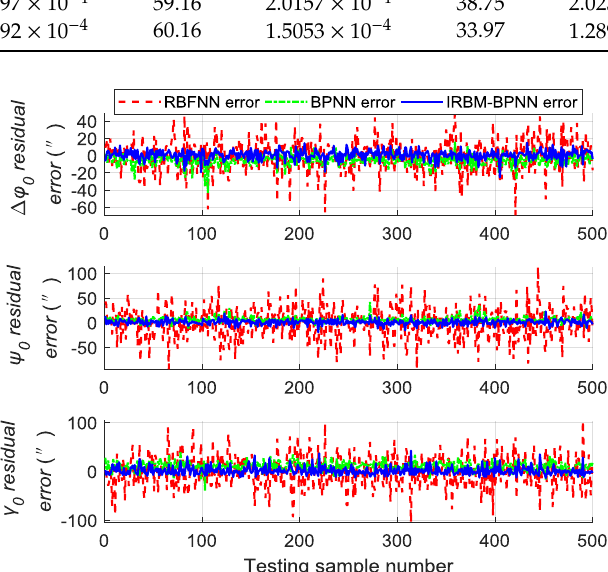
Figure 13. Contrast results of initial alignment residual error using three methods.